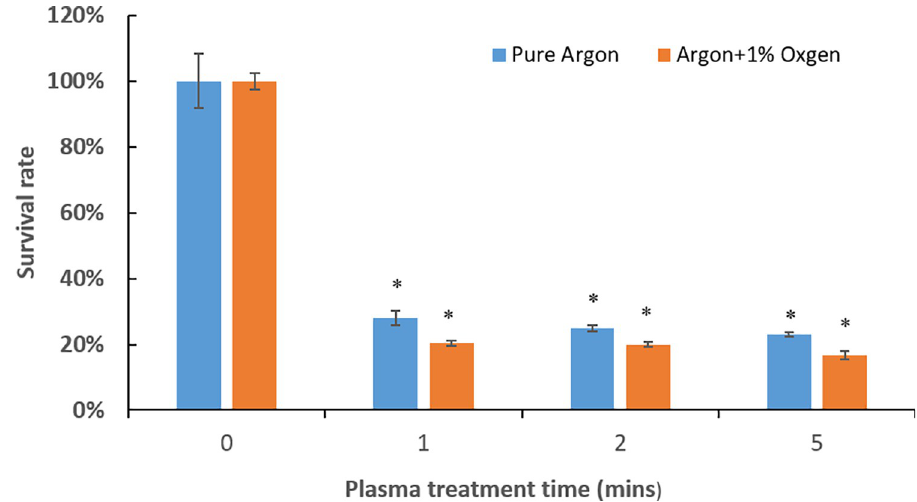
Fig 2. MTT assay results of the change of survival percentage of 3-day P . gingivalis biofilms with plasma treatment time. � denotes statistically significant difference compared with the control group with p < 0.05. Treatment time of 0 minutes represents the untreated control